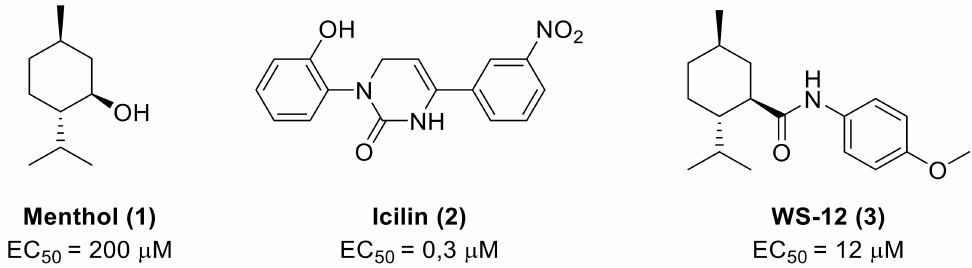
Figure 1. Model TRPM8 agonists (most widely used in pharmacological